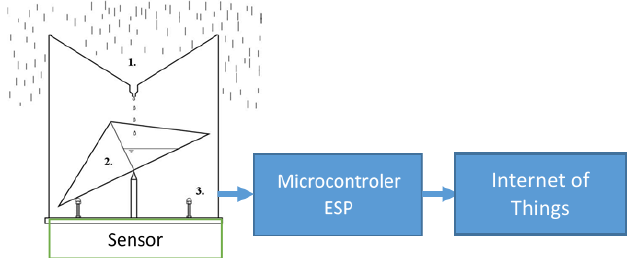
Figure 4. Design of rainfall intensity measuring